Question: Condense the content of this figure into a single sentence.
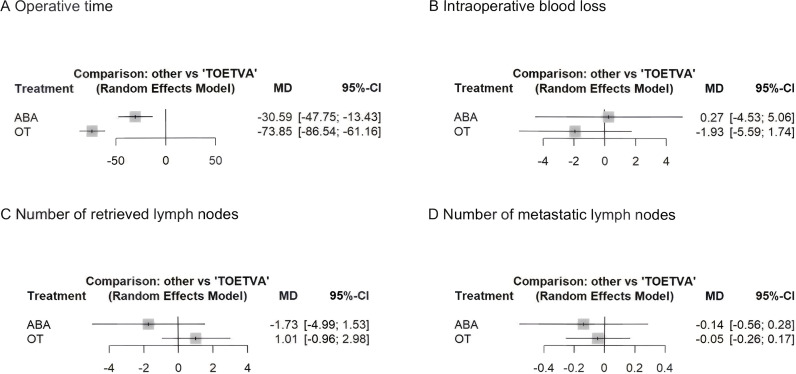
Answer: Network meta-analysis results for intraoperative outcomes. Standardized mean differences (SMD) with 95% confidence intervals (CI) containing a value of 0 were considered insignificant. TOETVA, transoral endoscopic thyroidectomy vestibular approach; OT, open thyroidectomy; ABA, endoscopic thyroidectomy via the axillary breast approach; vs., versus. (A) , Forest plot shows comparison of the operative time in minutes. (B) , Forest plot shows comparison of the intraoperative blood loss in ml. (C) , Forest plot shows comparison of the number of retrieved lymph nodes. (D) , Forest plot shows comparison of the number of metastatic lymph nodes.